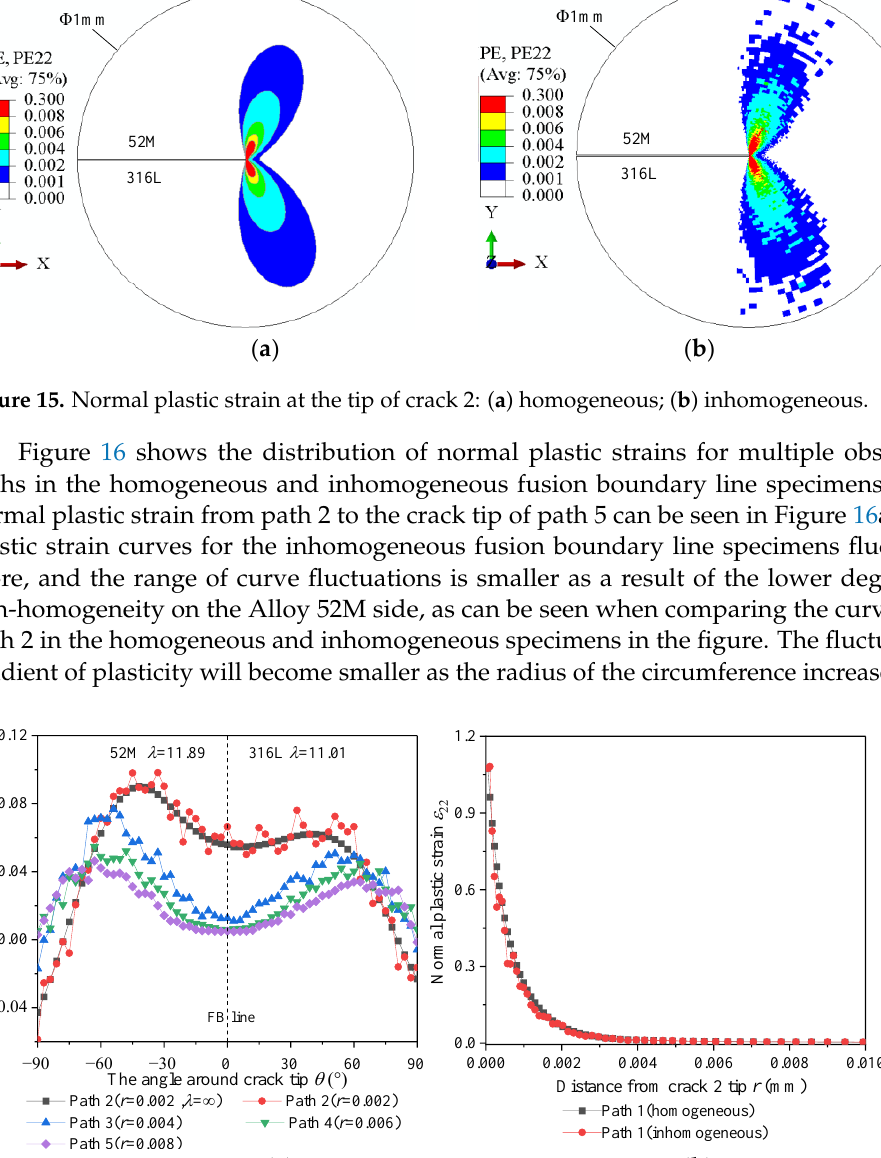
Figure 16. Normal plastic strain under homogeneous and inhomogeneous conditions: ( a ) around the crack 2 tip; ( b ) in front of the crack 2 tip.